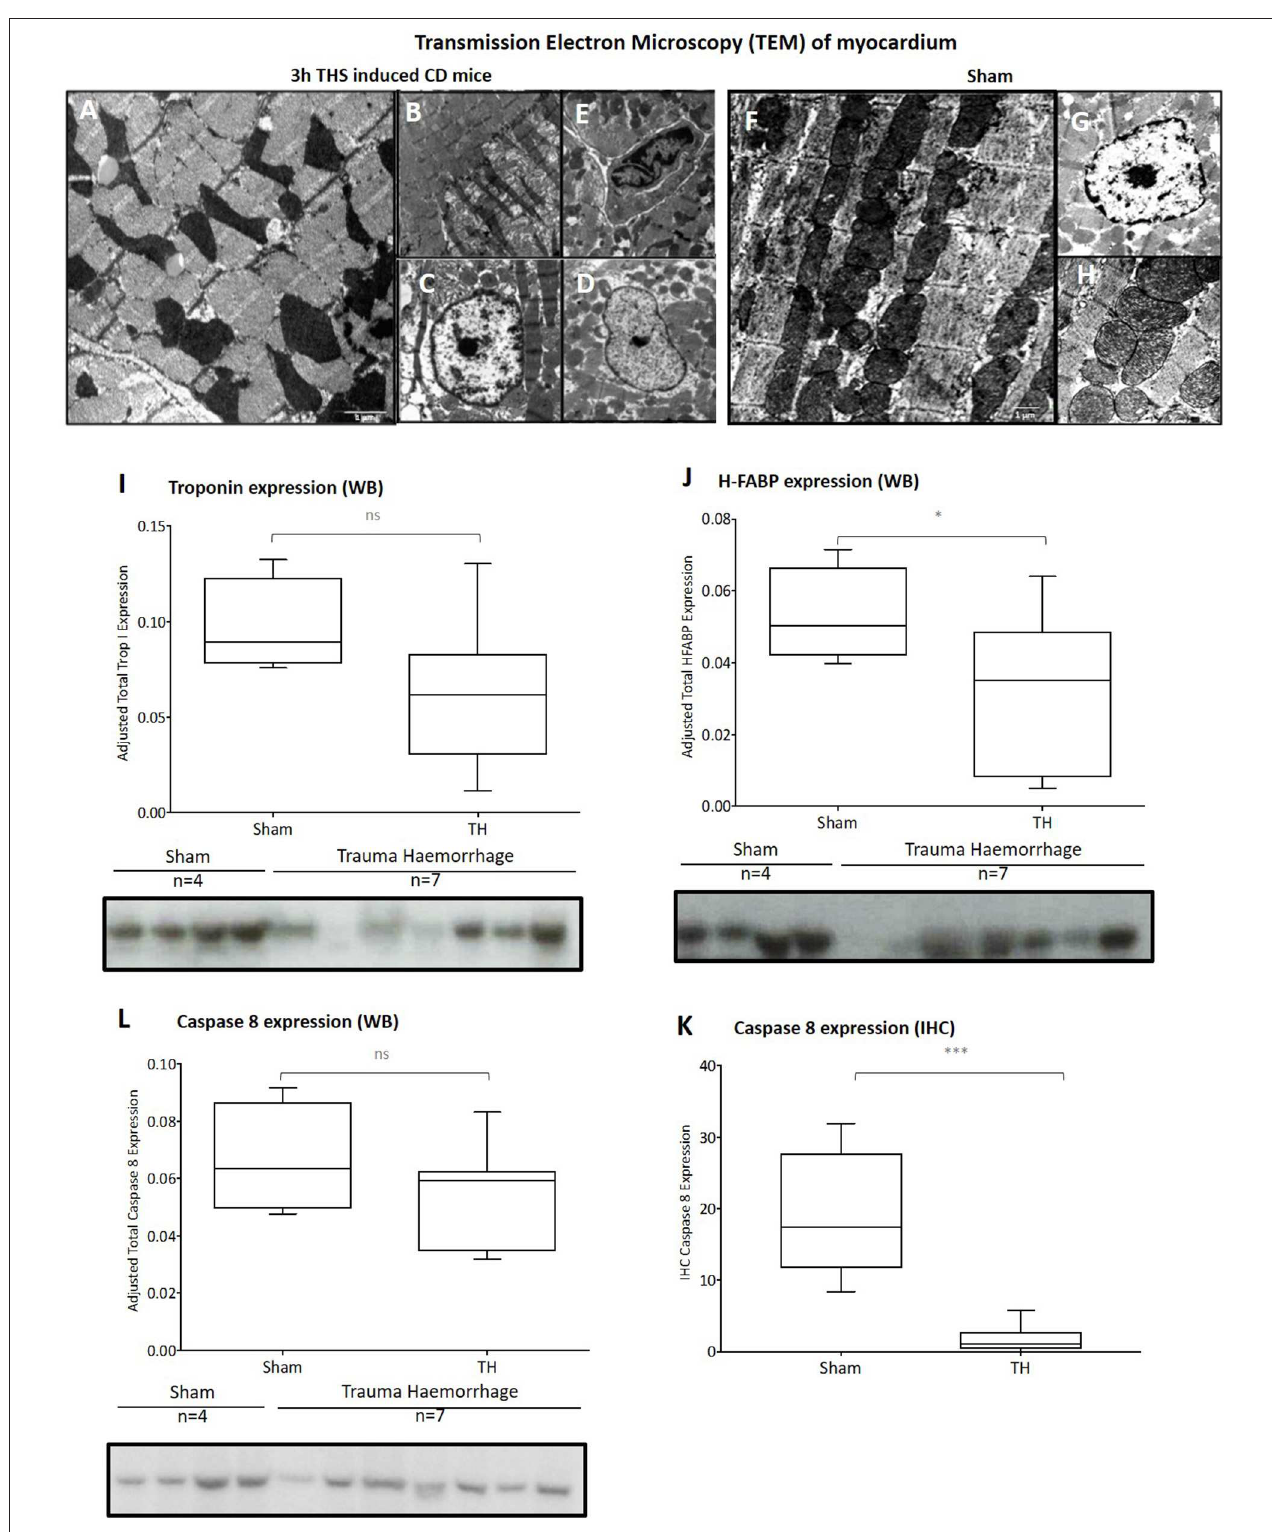
FIGURE 4 | Myocardial injury in the trauma hemorrhage induced CD murine model. TEM shows severe myocardial injury in the heart of THS mice, with interstitial oedema, widespread disorganization of the myoc ardium with relaxation of the sarcomere and poorly circumscribed mitochondria distributed in a disorderly